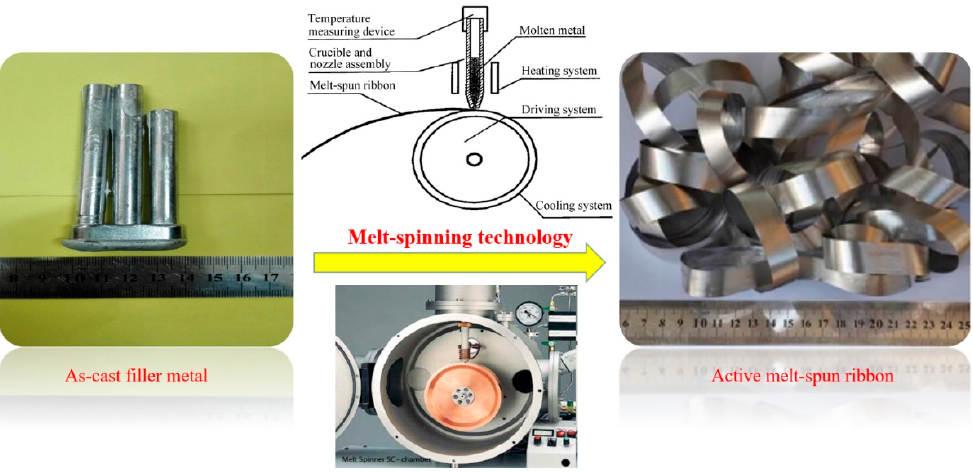
Figure 2. Schematic of the melt-spun ribbon preparation process.